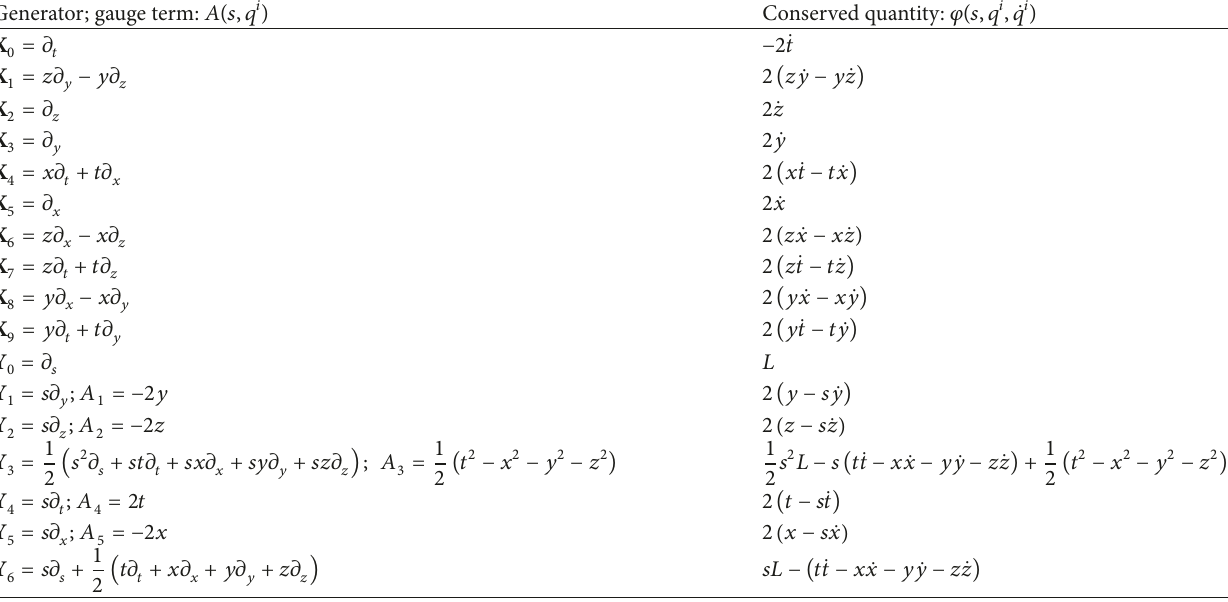
Table 1: Conserved quantities corresponding to each Noether